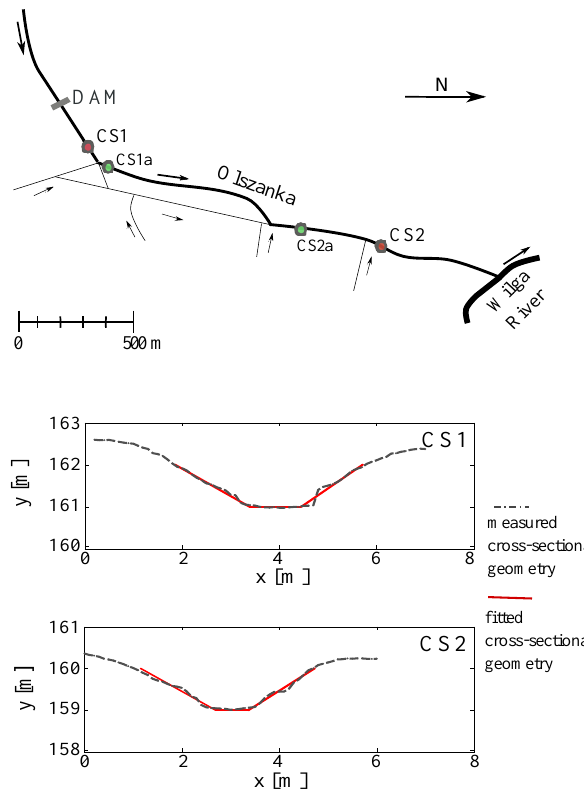
Figure 1. The site of the experiment in the Olszanka watercourse (upper panel), and the shape of measurement cross sections CS1 and CS2 (lower